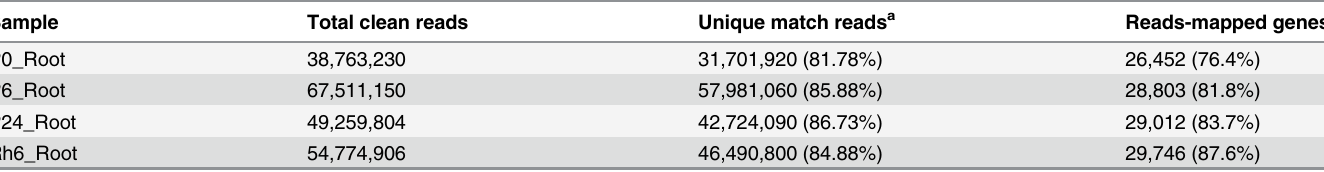
Table 4. Statistics of clean reads mapped to the primary root transcriptome of A . sparsifolia .